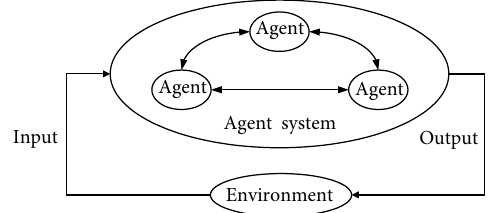
Fig. 2 Schematic of the Multi-agent